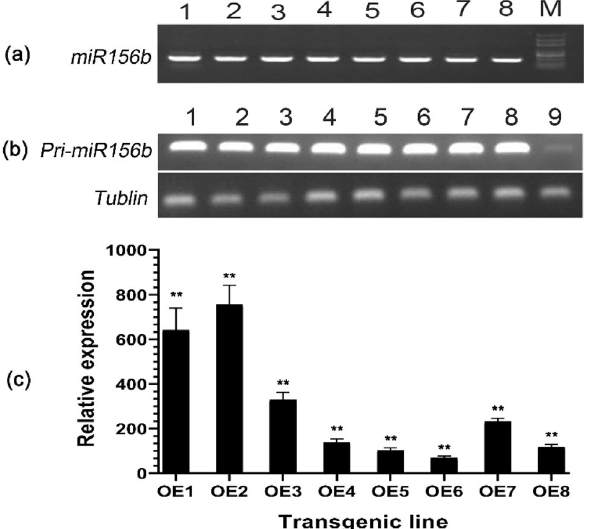
Figure 2. Verification of transgenic events and quantification of GmmiR156b expression in Arabidopsis seedlings. ( a ) PCR confirmation of positive transgenic Arabidopsis plants carrying GmmiR156b by gene-specific primers. ( b ) RT-PCR analysis of pri-GmmiR156b in the leaf of the wild type (WT) and eight independent transgenic lines. ( c ) Quantitative RT-PCR analysis of mature GmmiR156b in 8 overexpression (OE) lines. The relative expression level of mature GmmiR156b was normalized to that of the inner reference gene Tublin . Lanes 1–8, transgenic lines; lane 9, the WT. M, DNA marker DL2000. ** Indicates statistical difference between GmmiR156b and reference gene at P < 0.01. Original gels are presented in Supplementary Fig.